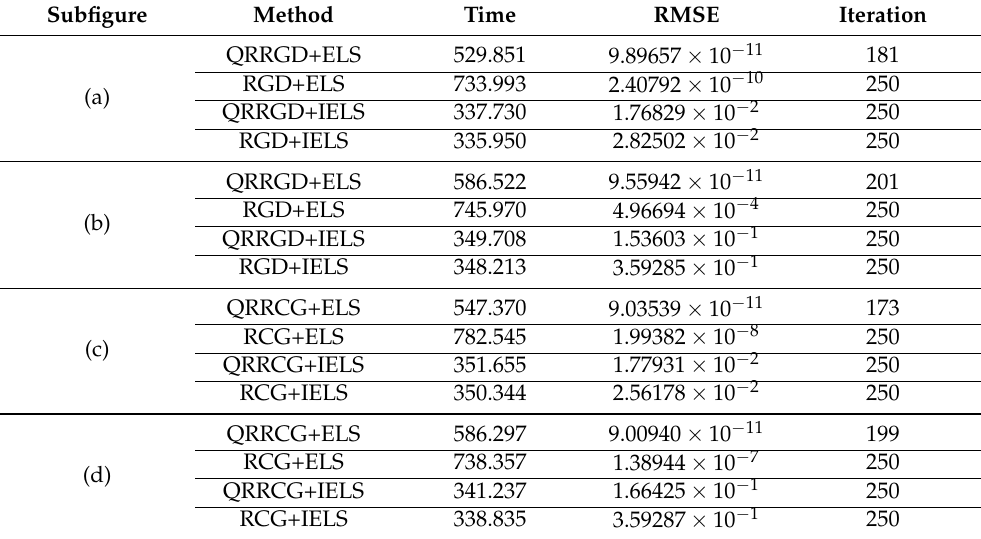
Figure 4. Performance comparison of the RCG with and without QR factorization. Simulations were carried out on square matrices M 1 ( a , c ) and M 2 ( b , d ). We apply ELS and IELS to find the step size. The parameter values are n 1 = 4000, n 2 = 4000, r = 36, and p = 0.05. Table 4. Computational results for Figure 4 with matrices size of 4000 × 4000. The time is rounded to three decimal places and RMSE is rounded to five decimal